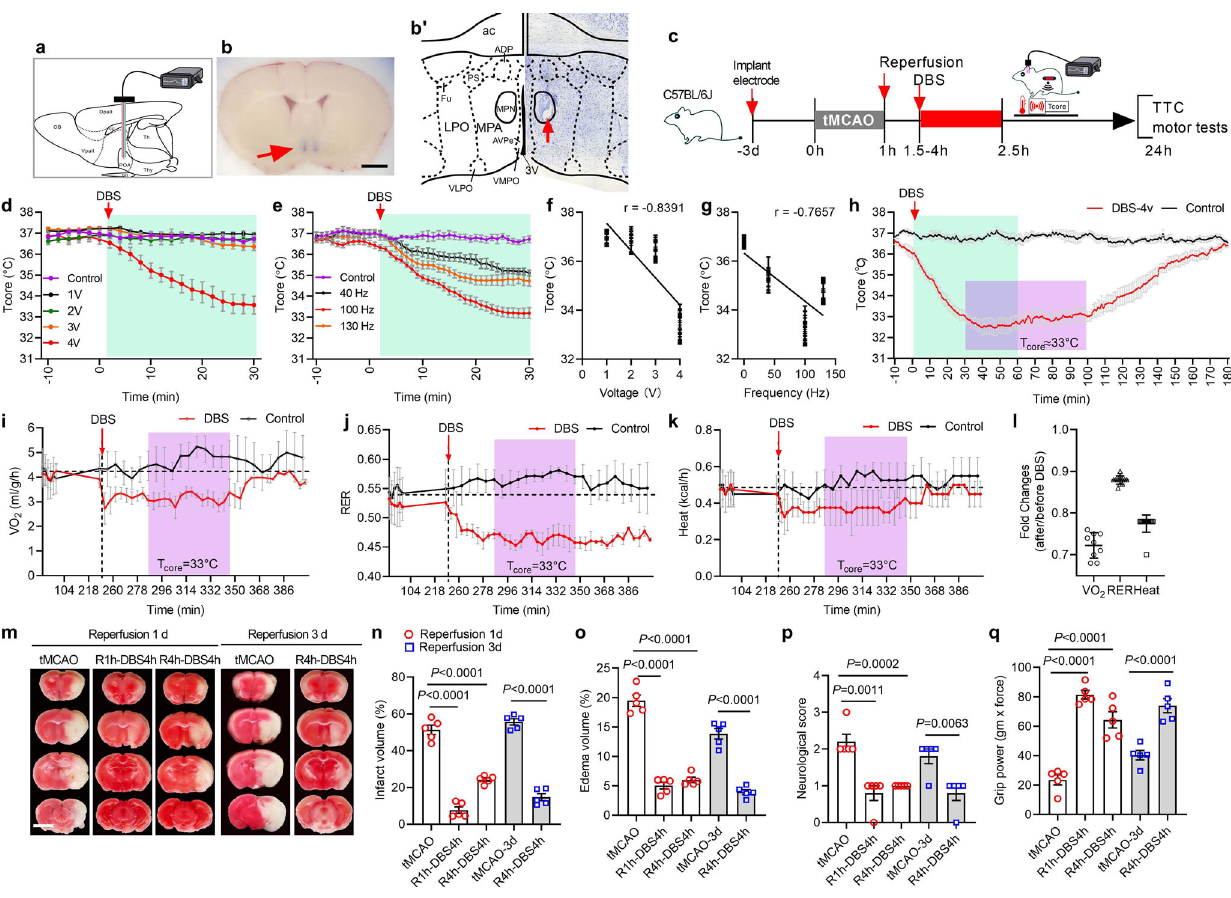
Fig.3|Deepbrainstimulation(DBS)-evokedhypothermiaprotectedischaemic brain. a Schematic representation of a bipolar electrode trajectory to the bilateral medialpreopticnucleus (MPN). b Coronal brainsection showing the preopticarea (POA) sites injected with Evens blue (blue dots, red arrow). Scale bar=2mm. b ’ Electrical lesioning for DBS stimulation site. The brain section stained with crystal violet was superimposed with outlines for the POA structures to indicate the location of MPN (red arrow). c Schematic of experimental design. d The plot showedthe T core ofDBSmicestimulatedwithvariousvoltagesat100Hz. e Theplot showed T core ofDBSmicestimulatedwithvariousfrequenciesat4V.ThePearson ’ s correlationbetweenthe T core withvoltages( f )andfrequencies( g )wasshown. h The entire time course of DBS-evoked hypothermia. The green-coloured areas in